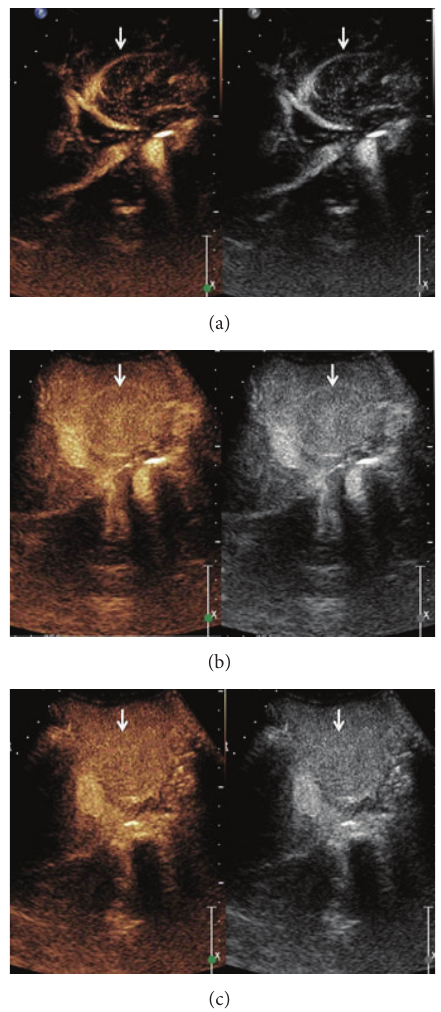
Figure 5: A 4-year-old boy with vague upper abdominal pain and abdominal distension since he was 2 years old. Peripheral enhance- ment of the lesion (a, arrow) is seen in the arterial phase of contrast enhanced US. The lesion becomes isoechoic to the adjacent liver parenchyma(b,arrow)inthevenousphaseofcontrastenhancedUS. The lesion retains contrast (c, arrow) in the delayed phase of contrast enhanced US. Points favouring nodular regenerative hyperplasia include arterial hyperenhancement and retention of contrast in the portal venous and delayed